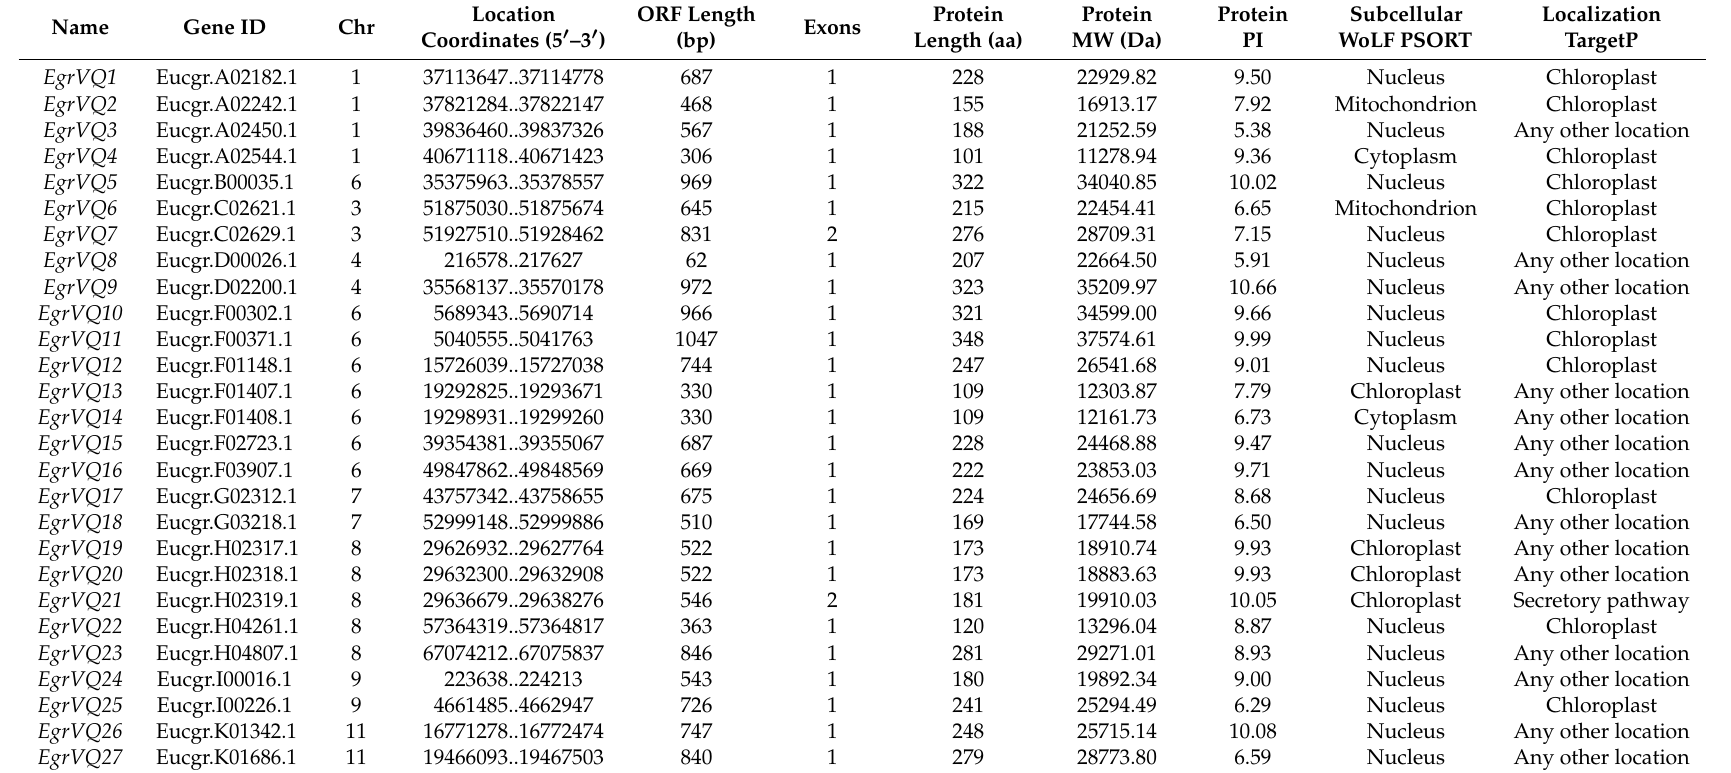
Table 1. The summary of 27 identified EgrVQ